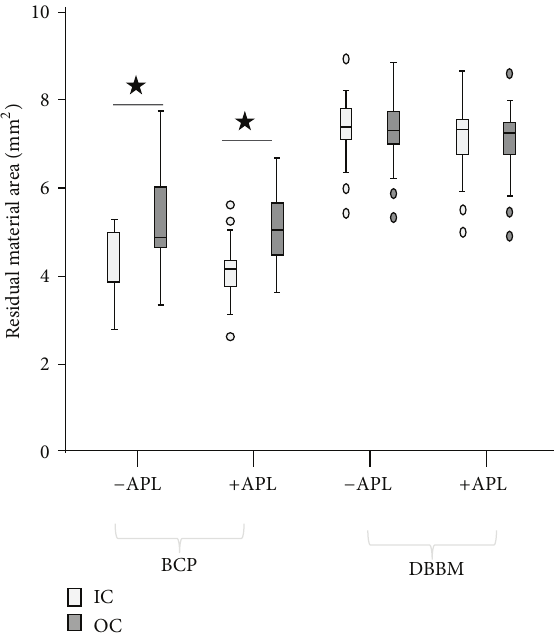
Figure 7: Box plot showing residual material distribution through- out the defect. In the defects filled with BCP, the amount of residual material was significantly ( ∗ P < 0.0001) higher in the outer zone (OC) than in the inner zone (IC) of the defect. In contrast, the amount of residual material present in the defects filled with DBBM was similar in the inner and the outer